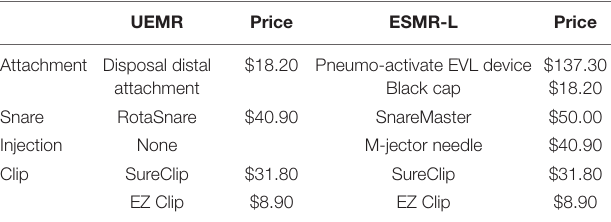
TABLE 1 | Comparison of device cost for underwater endoscopic mucosal resection without submucosal injection (UEMR) and endoscopic submucosal resection with a ligation device